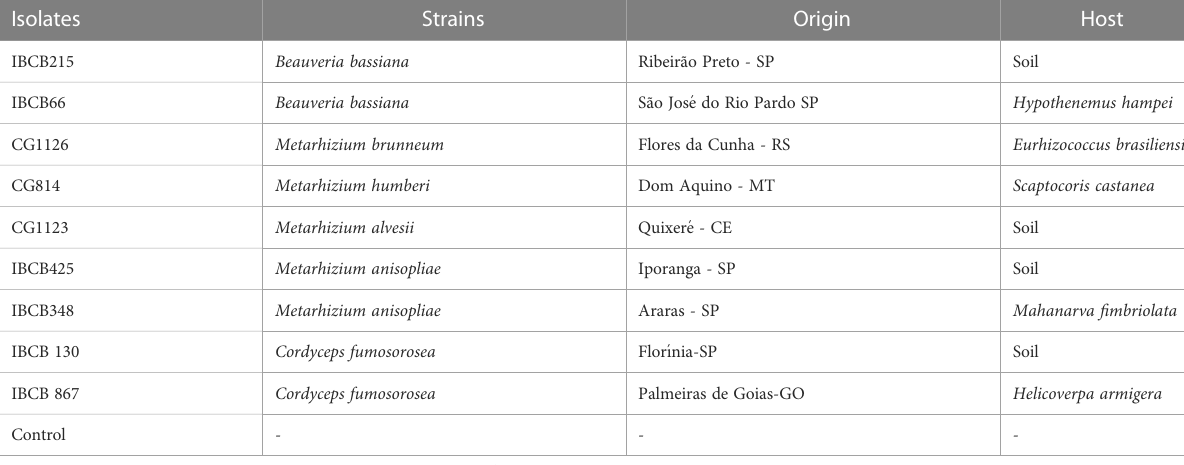
TABLE 1 Origin of entomopathogenic fungi used in the bioassays. Isolates